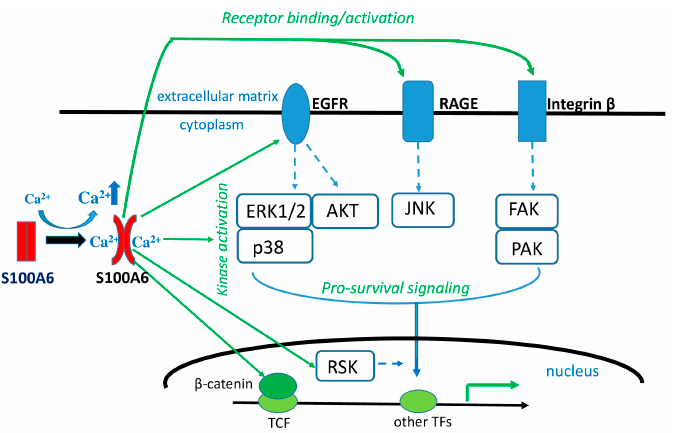
Figure 2. Role of intracellular and extracellular S100A6 in Ca 2+ -cellular signaling. Increased intracellular Ca 2+ level induces a conformational change of S100A6 molecule, which enables it to interact with various intracellular proteins or, following secretion, to bind to receptor proteins and activate signaling pathways and, ultimately, gene transcription that leads to cell survival/proliferation. TF—transcription factor.